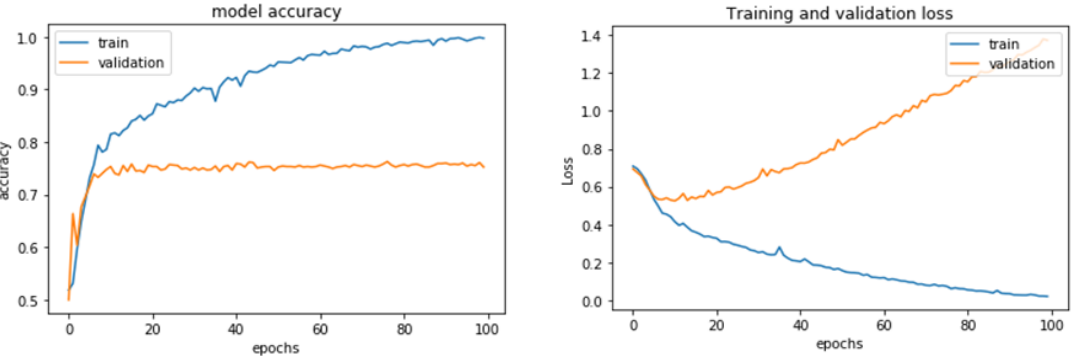
Figure 10. Accuracy and loss model of FFT_1D-CNN.